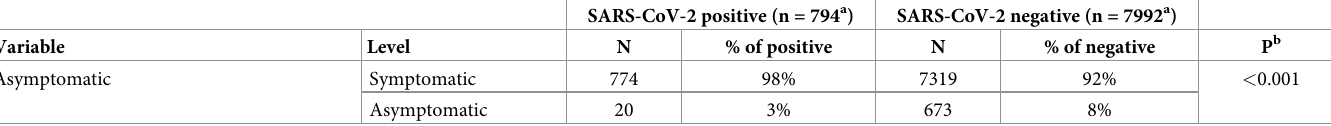
a Number missing for each variable: Health professional: 129, Gender 40, Smoking 107, Fitness 11, Household Income 2225. Symptoms were checkboxes without a “no” alternative. b p-value for unadjusted logistic regression comparing those without the trait with those with the trait. For multi-level traits, the p value was calculated using